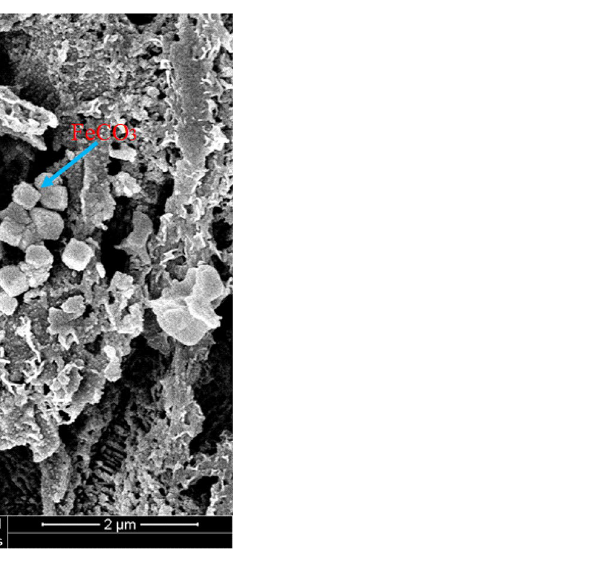
Figure 10. SEM of FeCO 3 crystal attach to Fe 3 C